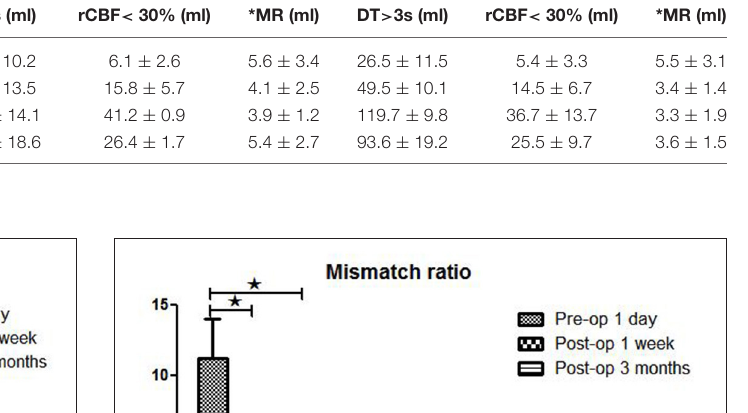
TABLE 2 | WB-CTP showing hemodynamic characteristics in ischemic MMD patients of different Suzuki stages at different time points (1 day before bypass, 1 week after bypass and 3 months following bypass). Pre-operative 1day Post-operative 1 week Post-operative 3months